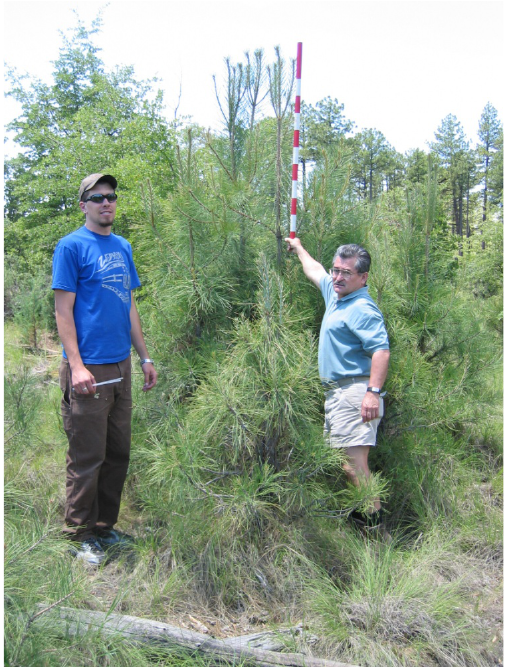
Figure 7. In the foreground is a grazed ponderosa pine sapling. In the background ponderosa pine saplings have begun rapid vertical growth after escaping the reach of browsing